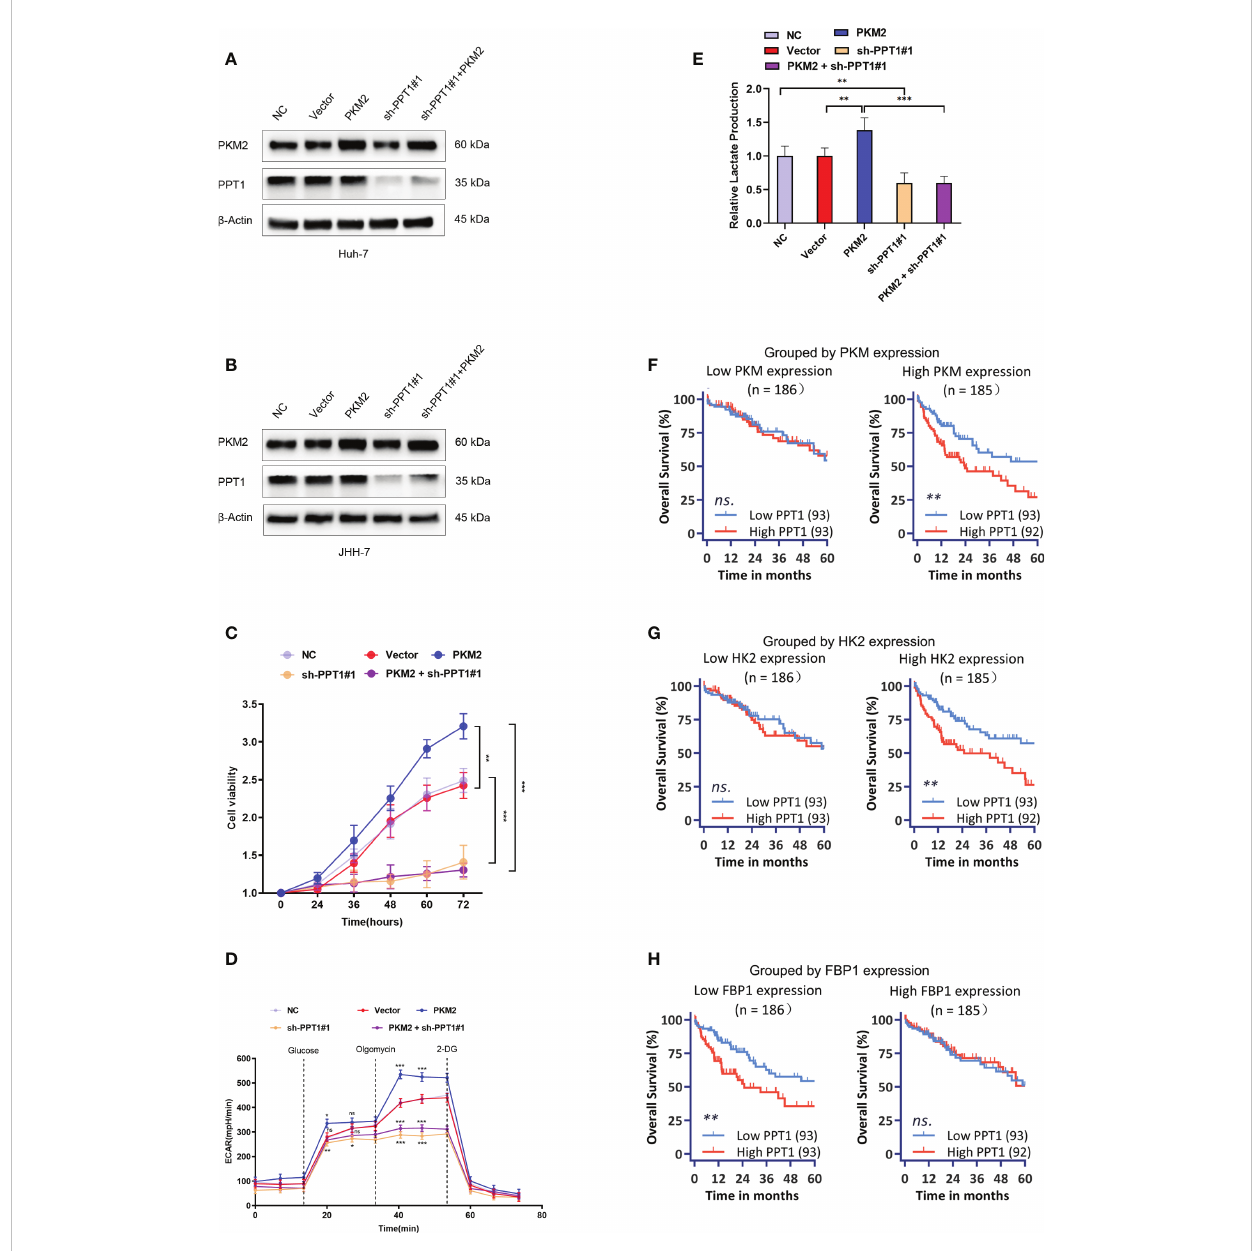
FIGURE 8 Effect of PPT1 knockdown on human HCC cells. (A, B) Stable knockdown of PPT1, and overexpression of PKM2 in Huh-7 (A) and JHH-7 (B) cells by lentiviral vector transfection. The knockdown effect on protein levels were shown for normal control cells (NC), cells transfected with empty vector (Vector), PPT1 knockdown cells (sh-PPT1#1), PKM2 overexpression cells (PKM2), and combination of PKM2 overexpression and PPT1 knockdown (PKM2 + sh-PPT1#1). b -Actin was used as a loading control. (C) In vitro cell proliferation curves showing the effect of PKM2 overexpression, PPT1